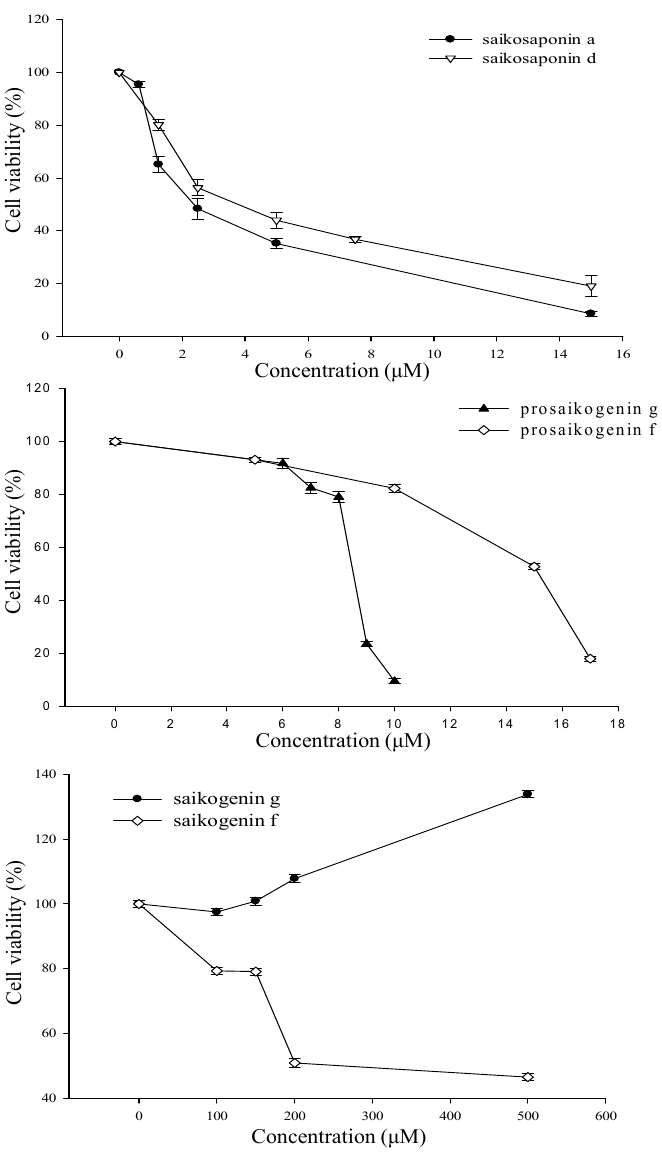
Figure 5. Effect of saikosaponin A, saikosaponin D, prosaikogenin F, prosaikogenin G, saikogenin F, and saikogenin G on proliferation of HCT 116 cells. Cell proliferation was determined by CCK-8 assay.